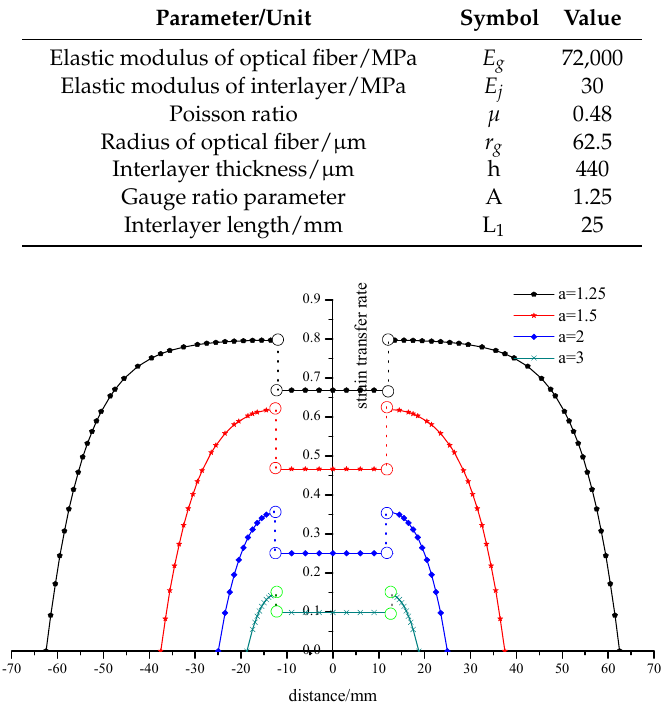
Figure 4. The axial distribution of FBG strain transfer rate.